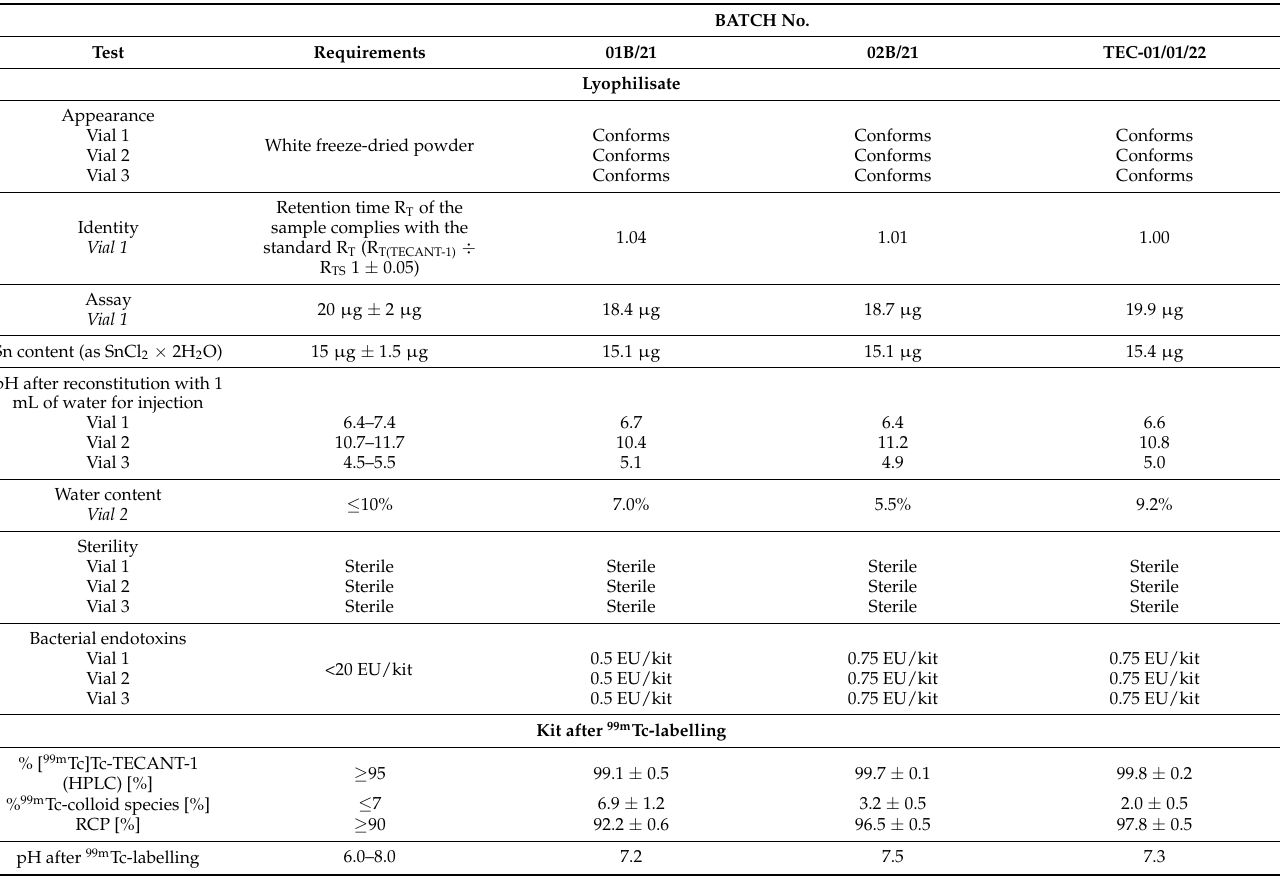
Table 6. Batch analysis—test and requirements, methods and batch results for batches 01B/21, 02B/21 and TEC-01/01/22.